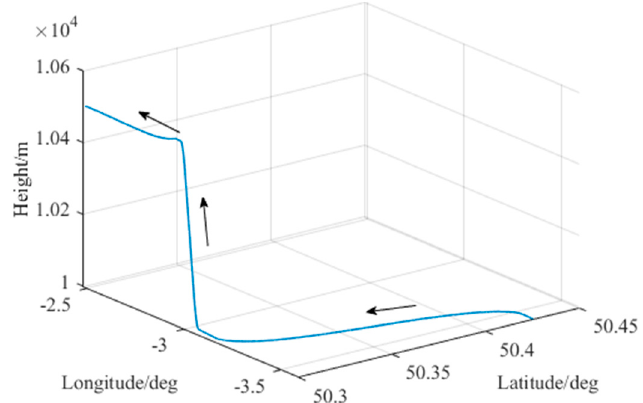
Figure 6. Simulated trajectory of the aircraft. Sensors 2019 , 19 , x FOR PEER REVIEW